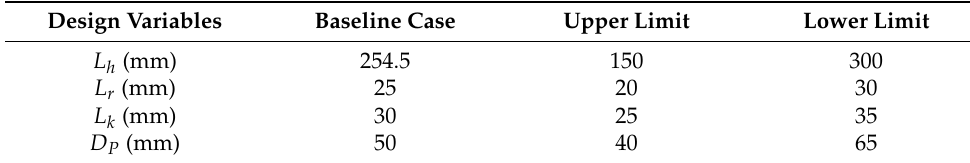
Table 4. Specifications of the baseline case and their bounded values.